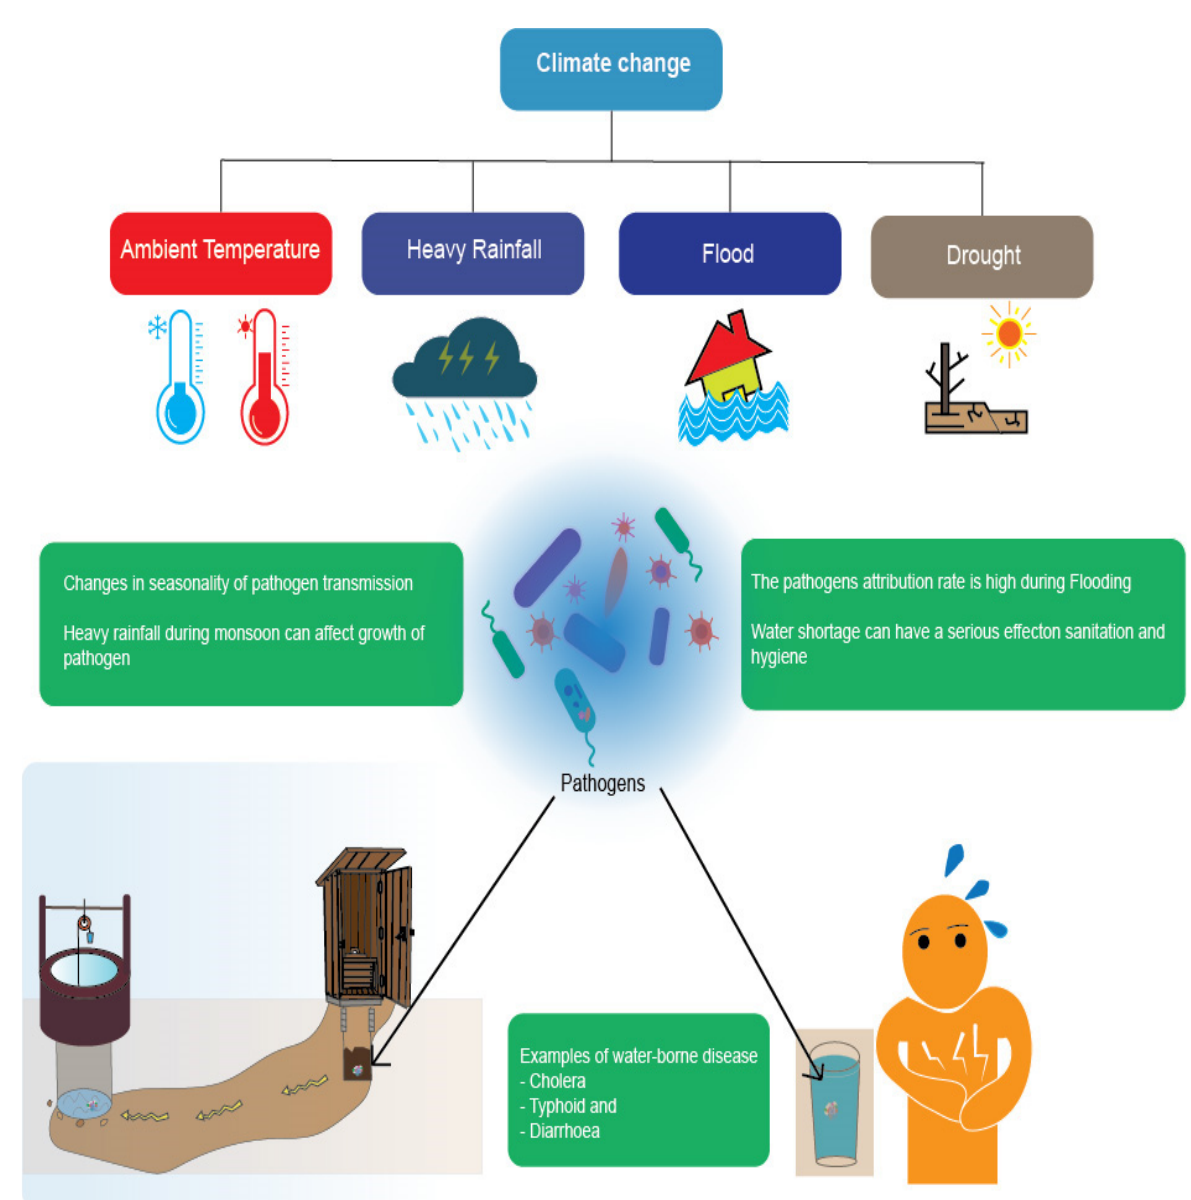
Figure 1. Graphical illustration of the impacts of climate change on the occurrence of water-borne diseases caused mainly by pathogens.